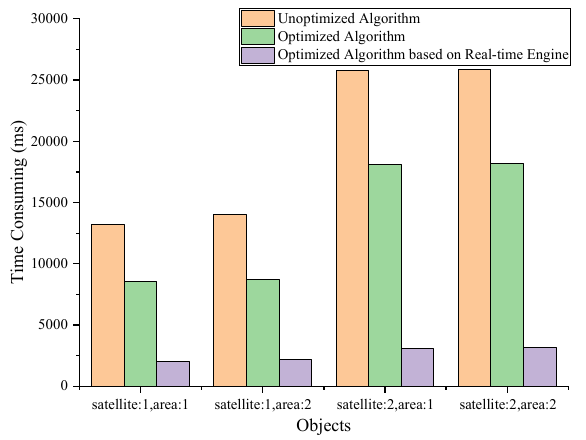
Figure 7. Time-consuming comparison of different calculation methods